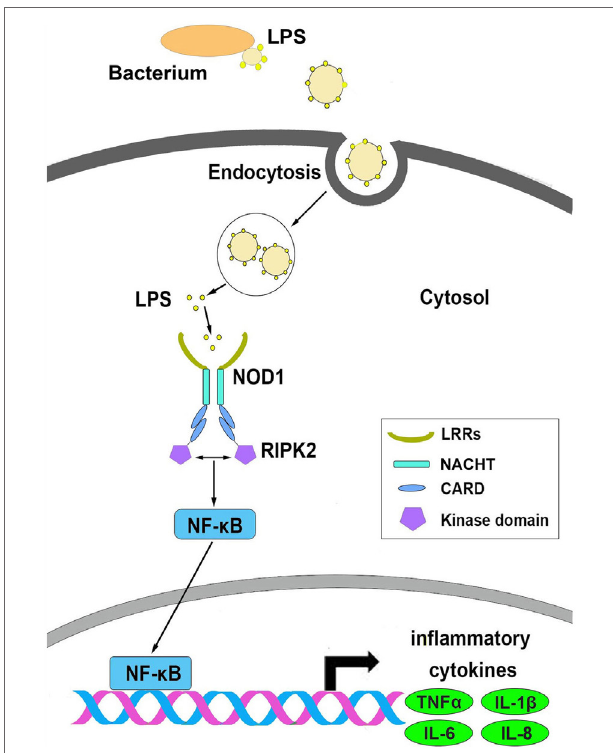
FigUre 10 | The possible signal pathways that explain the process of NOD1 recognition of lipopolysaccharide and activate NF- κ B signal pathway in miiuy